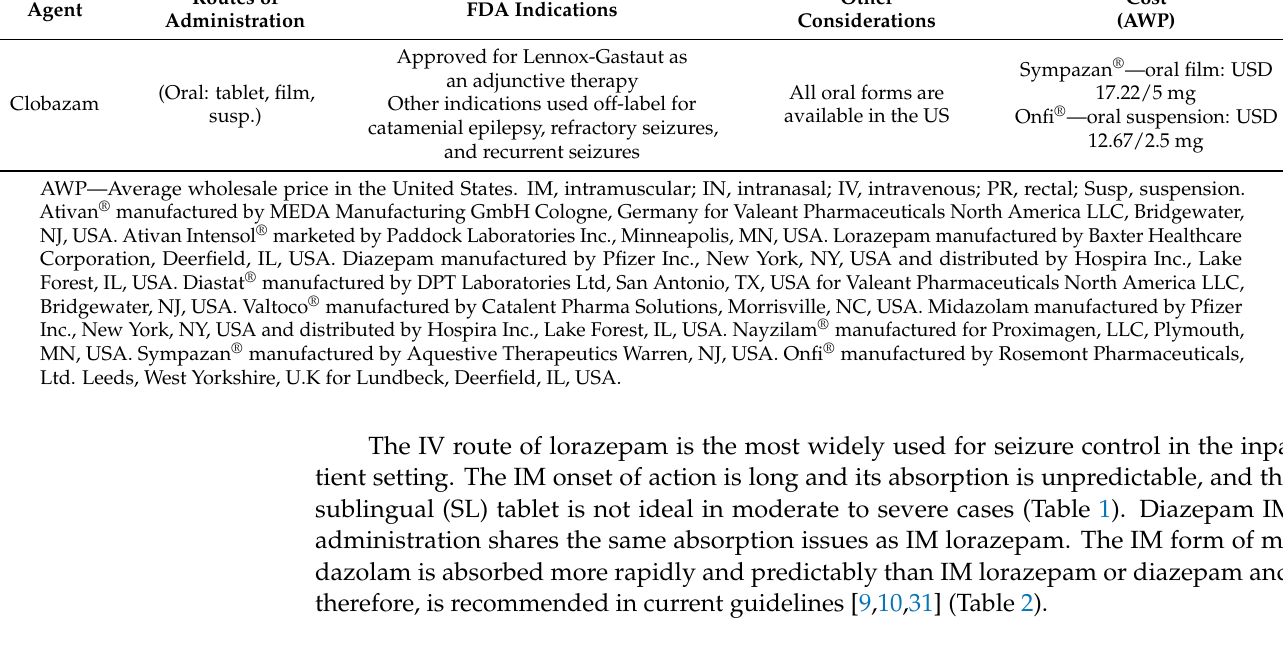
Table 2. Benzodiazepine pharmacokinetic and pharmacodynamic characteristics by route of administration